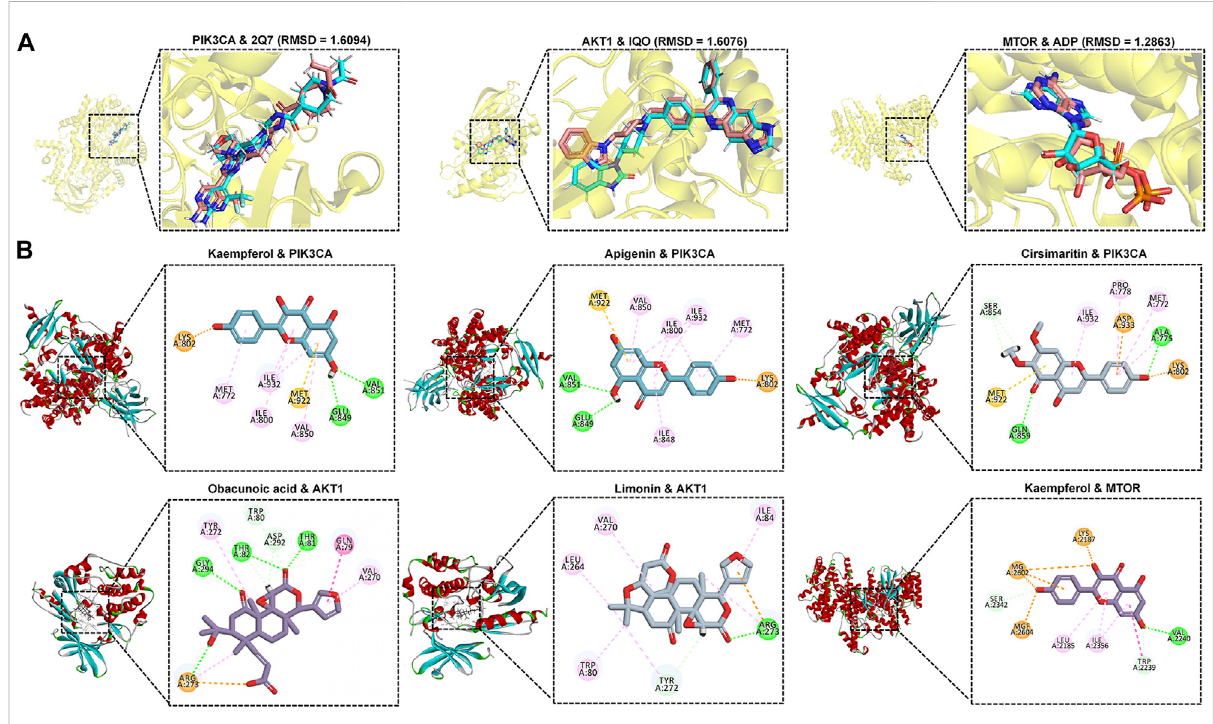
FIGURE 7 Molecular docking results of core components and potential targets. (A) RSMD of heavy ligands (blue) and co-crystalline ligands (pink) in selected target proteins (yellow). (B) Schematic diagram of the docking model of ligand-receptor molecules with strong af fi nity.